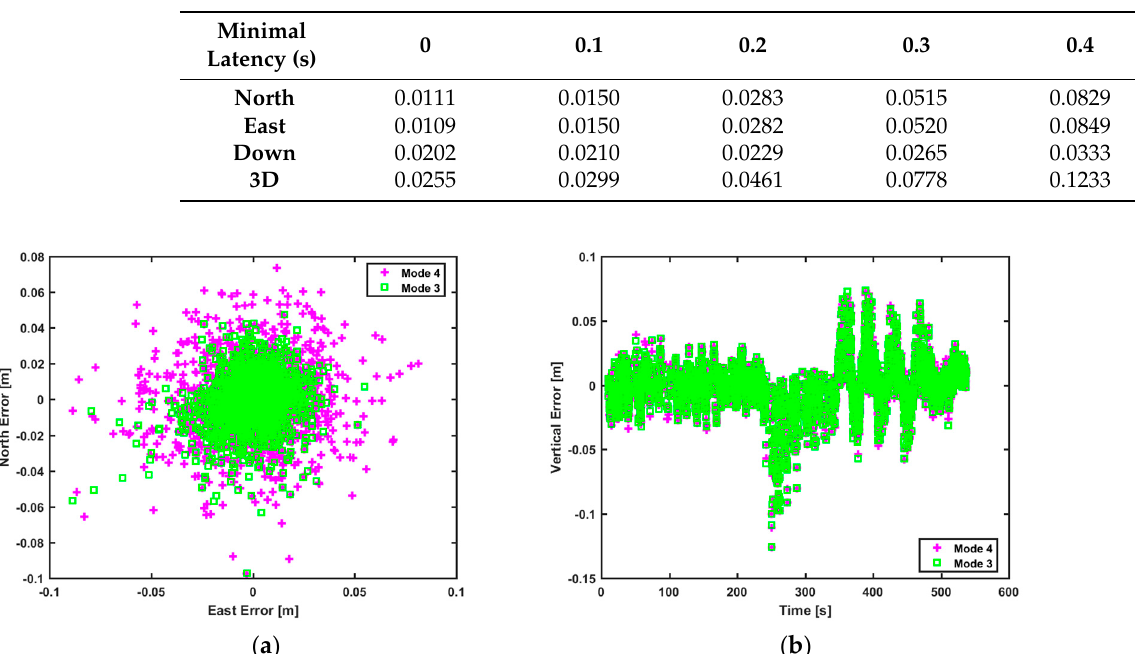
Table 4. RMSE with different minimal latencies of position increments in mode 3.